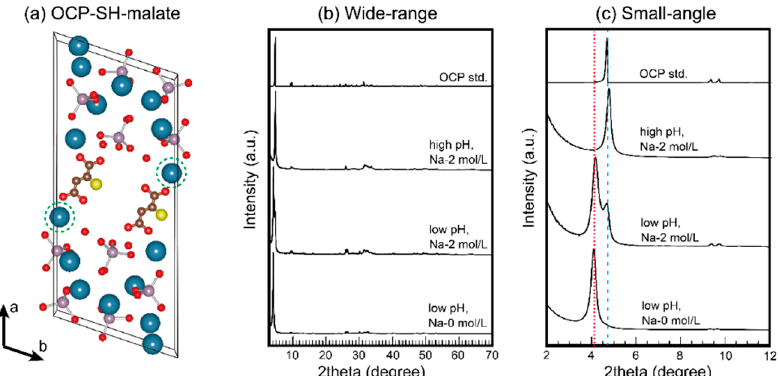
Figure 6. ( a ) Schematic illustration of SH-malate-substituted OCP. XRD patterns of treated samples in SH-malate substituted evaluation. ( b ) Wide range. ( c ) Small angle: the red dotted line indicates the main peak of OCP-SH-malate, and the broken blue line denotes the main peak of OCP-pure (conventional OCP). OCP std was calculated by Mathew et al. [28] and the VESTA3 program [30].